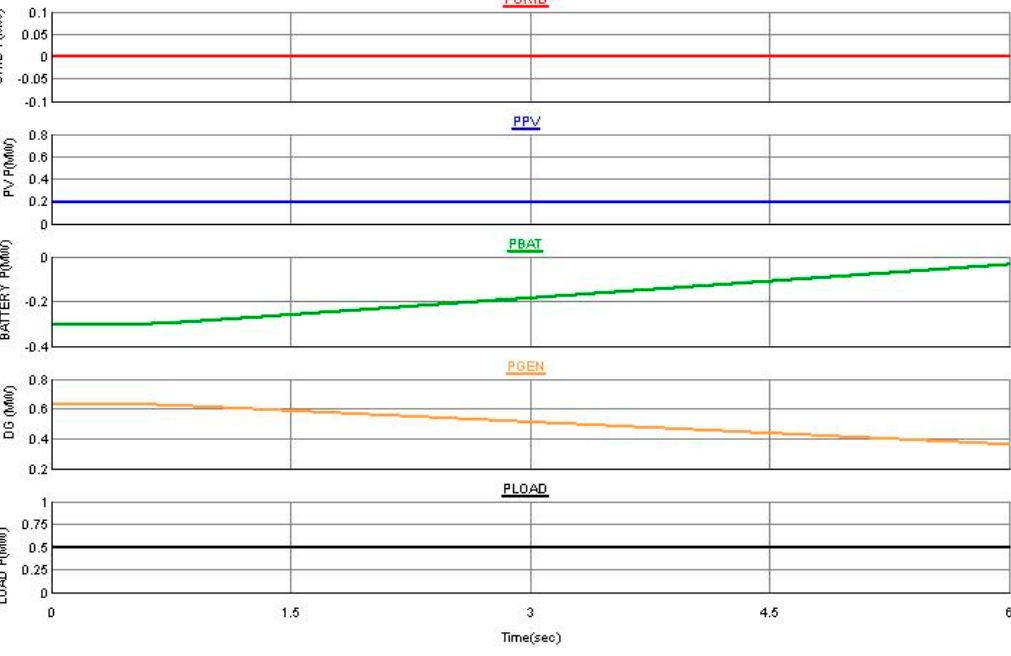
Figure 18. Grid power P GRID , PV array output power P PV , battery power P BAT , generator power P GEN and load power P LOAD.